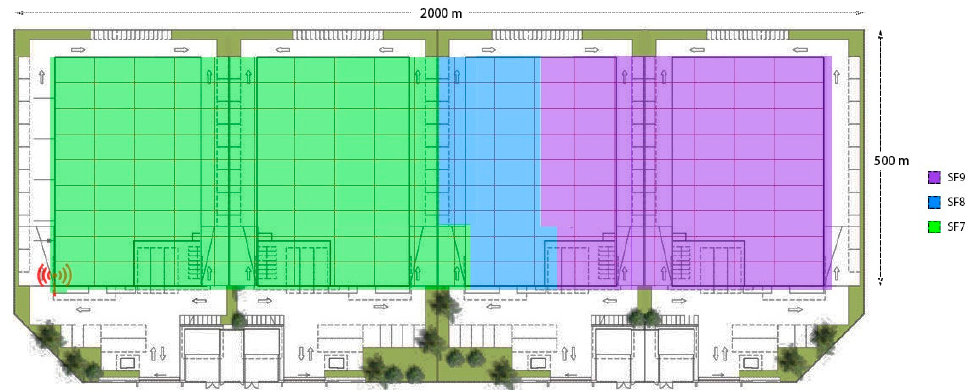
Figure 10. Results of SF for downlink traffic configured in every node at the end of the simulation, overlaid on the site map.